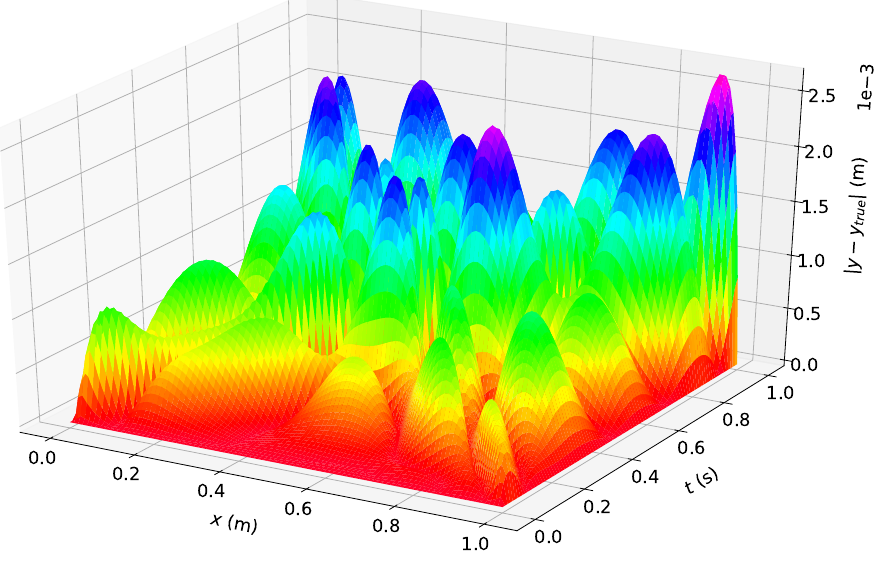
Figure 5. Problem 2 solution